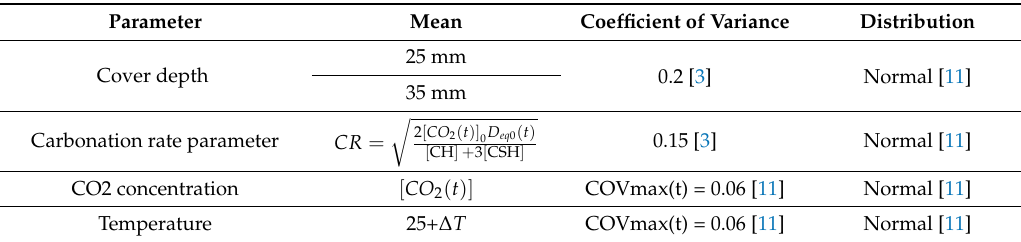
Table 2. Statistical parameters.